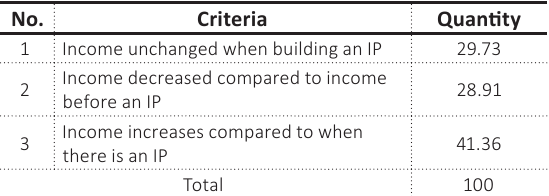
Table 4. Statistics of household income changes after building and developing an